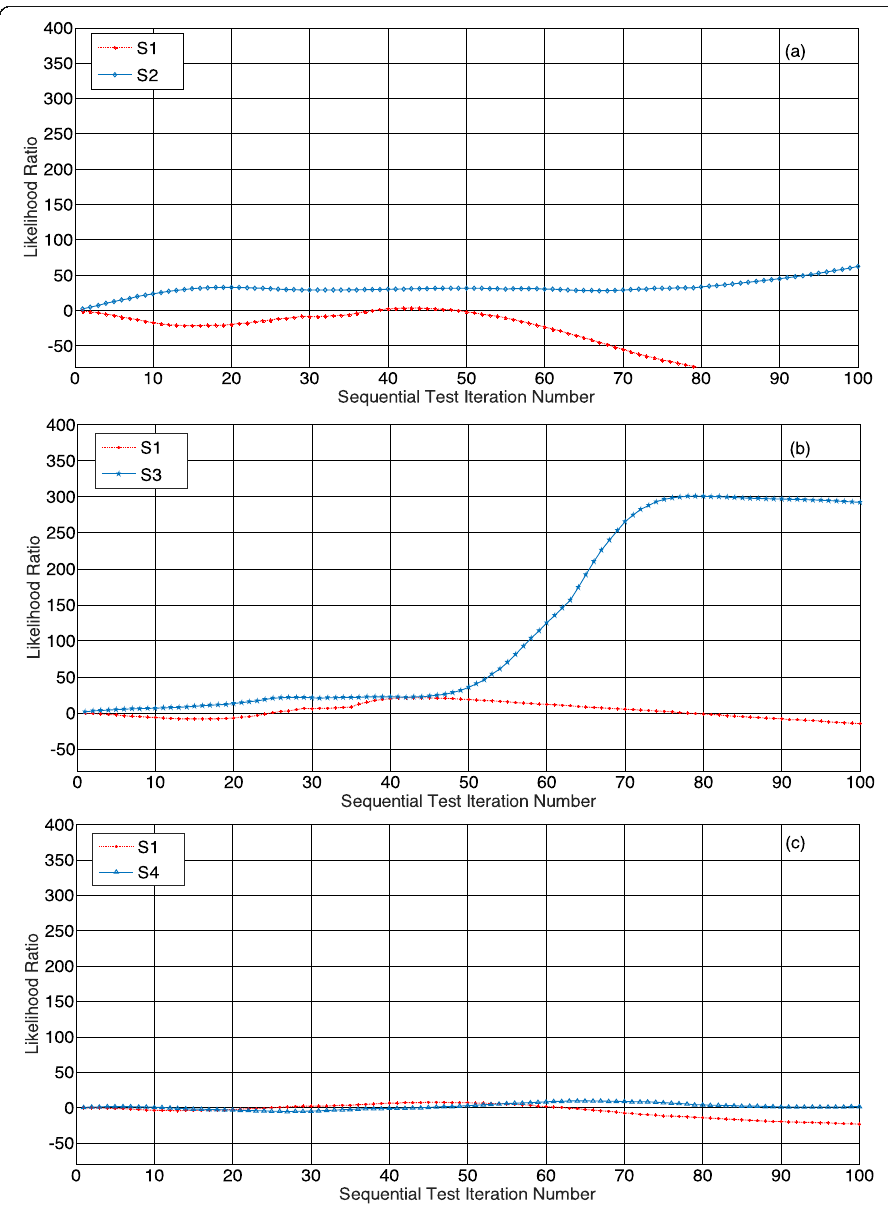
Fig. 23 Result of SPRT in variables λ 1, 2 , λ 1, 3 , λ 1, 4 with calculation